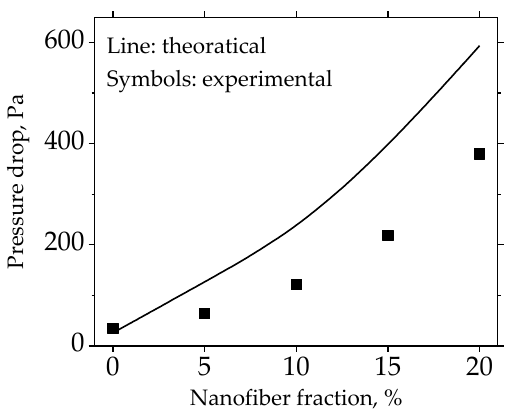
Figure 10. Experimental and theoretical pressure drop of filter paper.